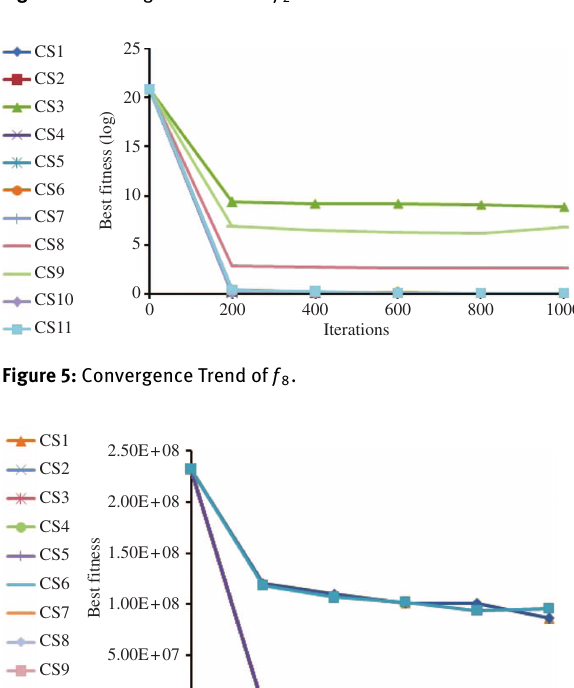
Figure 4: Convergence Trend of f 2 .